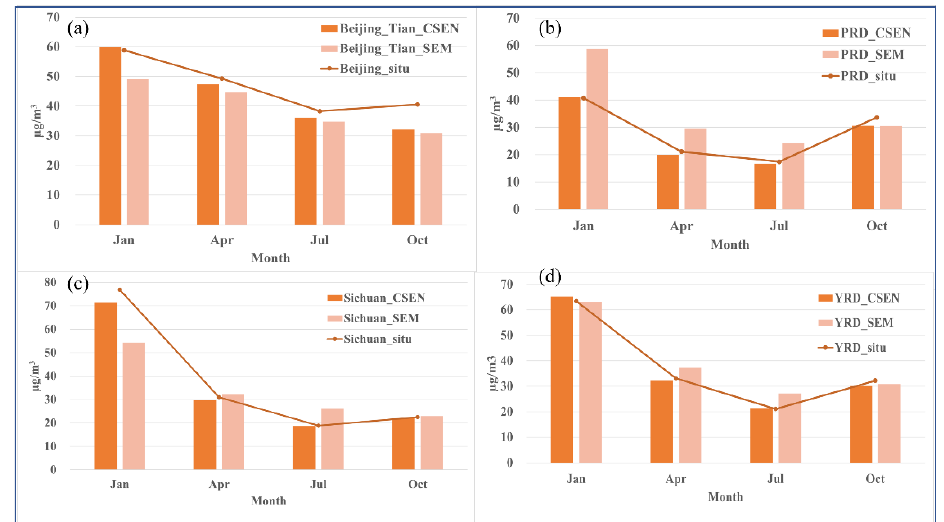
Figure 8. Comparison of the monthly average PM 2.5 concentration evaluated by CSEN and SEM with ground-observed data in ( a ) Beijing – Tianjin, ( b ) PRD, ( c ) Sichuan, and ( d ) YRD. Table 2. Performance of the AOD – PM 2.5 algorithm with respect to the two methods in the four key urban clusters.